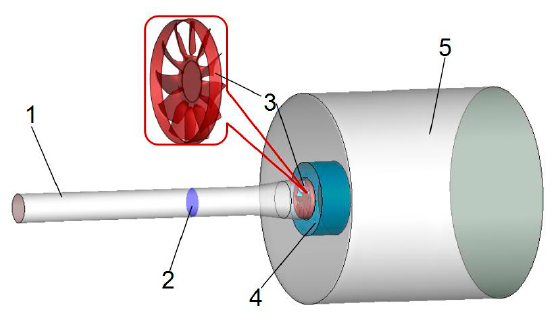
Figure 1. Simulation model of pneumatic performance of axial-flow cooling fan. 1—Inlet; 2—data monitoring surface; 3—cooling fan; 4—rotating domain; 5—outlet.